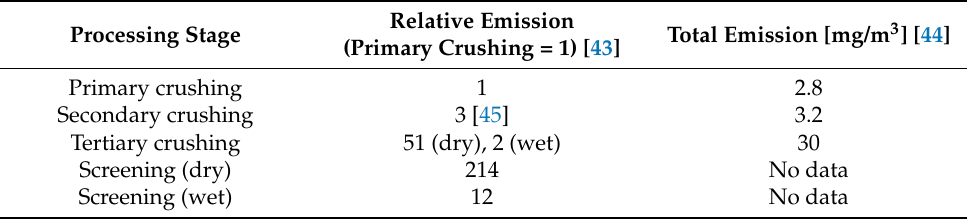
Table 4. The TSP emission of selected devices according to various investigations. Processing